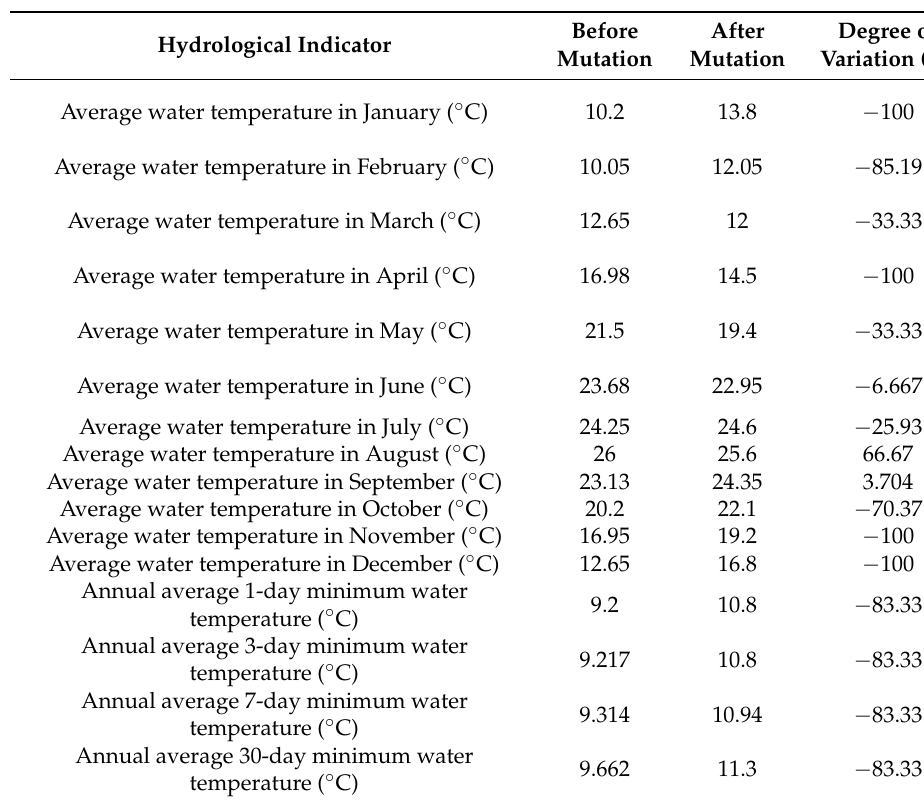
Table 4. Results of the indicator of Water Temperature Alteration analysis for Cuntan